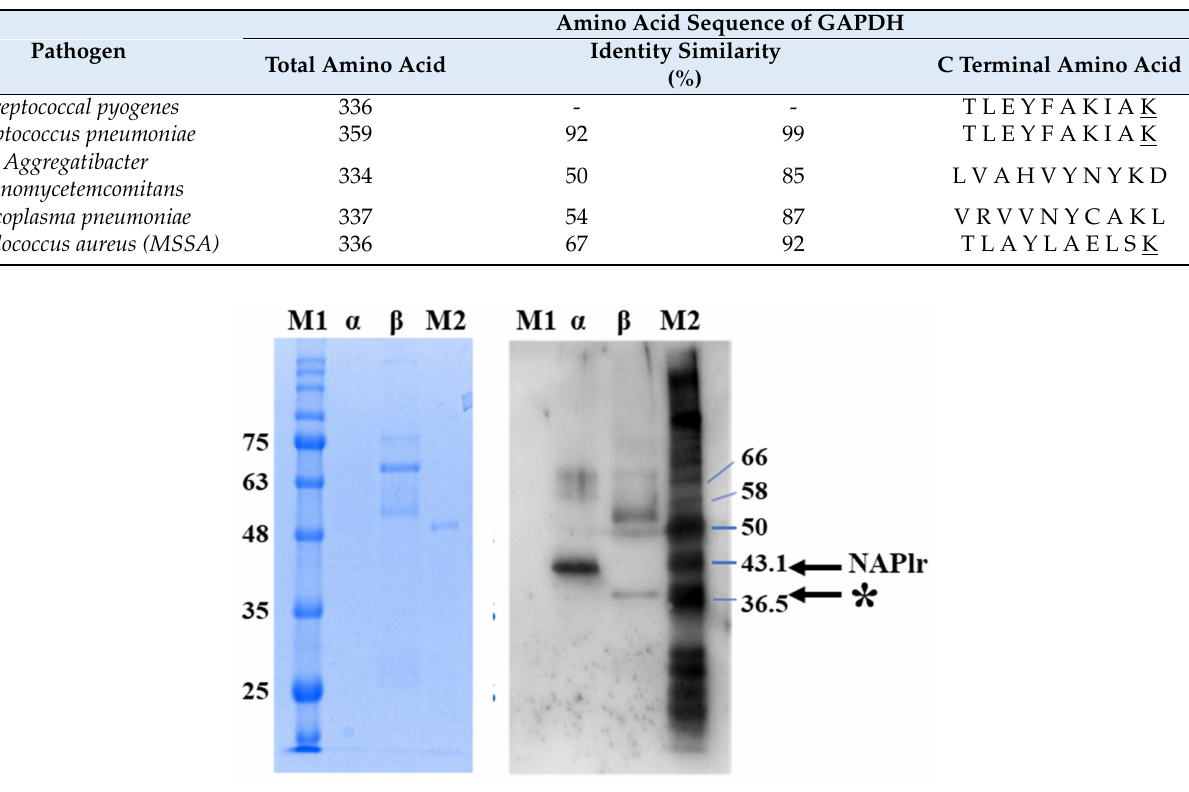
Figure 19. Western blotting analysis of isolated bacterial protein. Protein staining of the blot of isolated protein from M. pneumoniae and Streptococcus pyogenes (left) and Western blotting using anti-NAPlr antibody (right). Western blotting revealed a specific band in the β -lane at around the predicted size of M. pneumoniae GAPDH (37 kDa: indicated by * with arrow), confirming the cross-reactivity of the anti-NAPlr antibody with M. pneumoniae GAPDH. The strong band in the α -lane with a molecular mass of 43 kDa, indicated by the arrow, is the NAPlr protein. Lanes: M1, prestained marker; α = isolated protein of S. pyogenes ; β = isolated protein of M. pneumoniae ; M2, Western 7 Protein Ladder